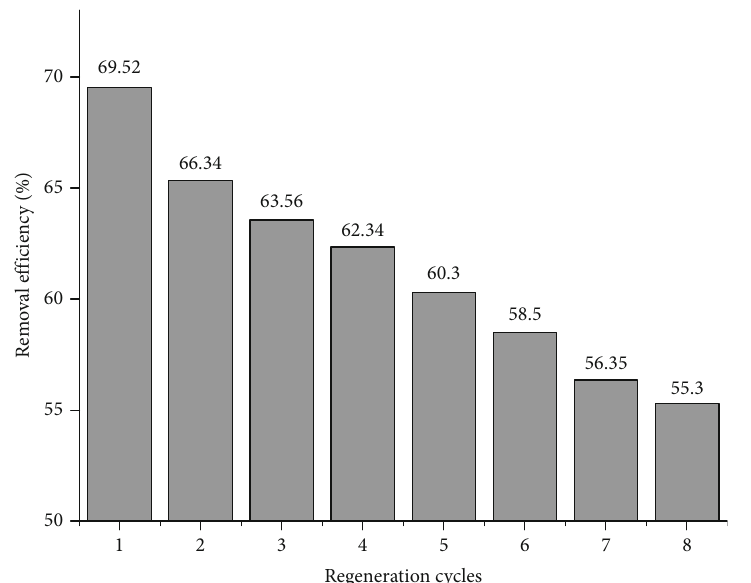
Figure 4: E ff ect of regeneration cycles on the removal of Cr (VI) by activated carbon with Fe3O4 nanocomposite.